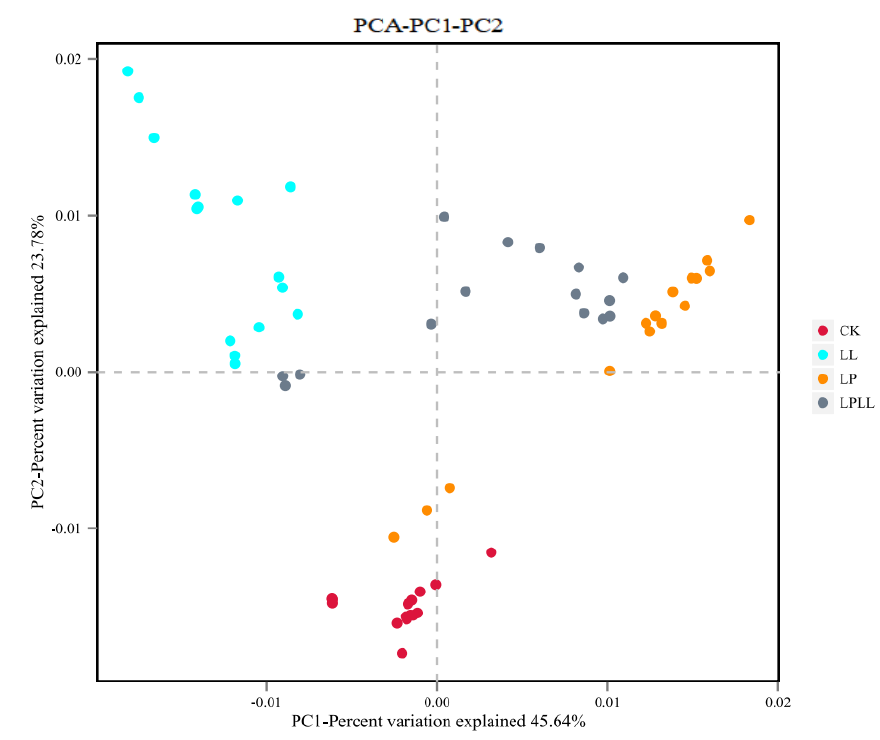
Figure 8. PCA of fermented sugarcane juice. CK: fresh sugarcane juice; LL: sugarcane juice with added HNK10; LP: sugarcane juice added with HNK21; LPLL: sugarcane juice treated with HNK10 + HNK21 was added.